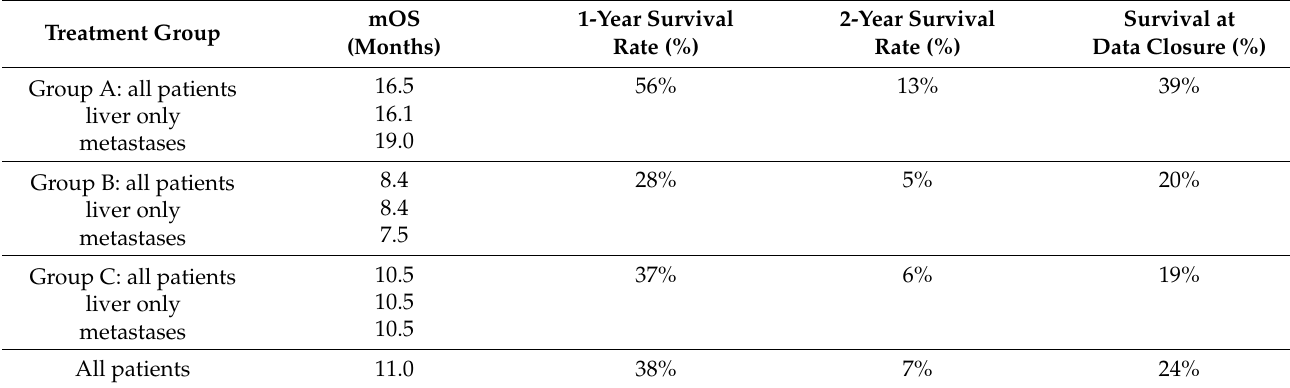
Table 4. Multivariate analysis of predictors for survival.